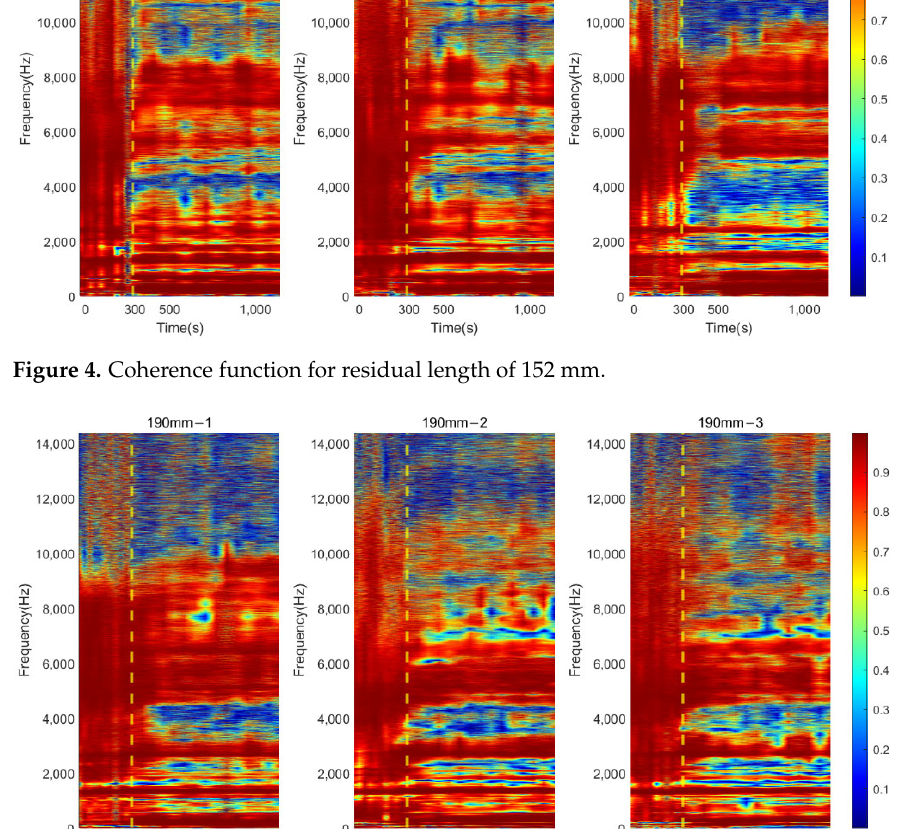
Figure 6. Coherence function for residual length of 228 mm. 3.2. Cross ‐ Spectrum Analysis Figures 7 and 8 exhibit the cross ‐ spectrum of the normalised magnitude, which are plotted in the frequency bandwidth of 8000 Hz for the three residual length conditions. The cross ‐ spectrums at cure times 0, 150, 300, 600, and 1140 s aim to show the magnitude change relative to the simulated osseointegration process.